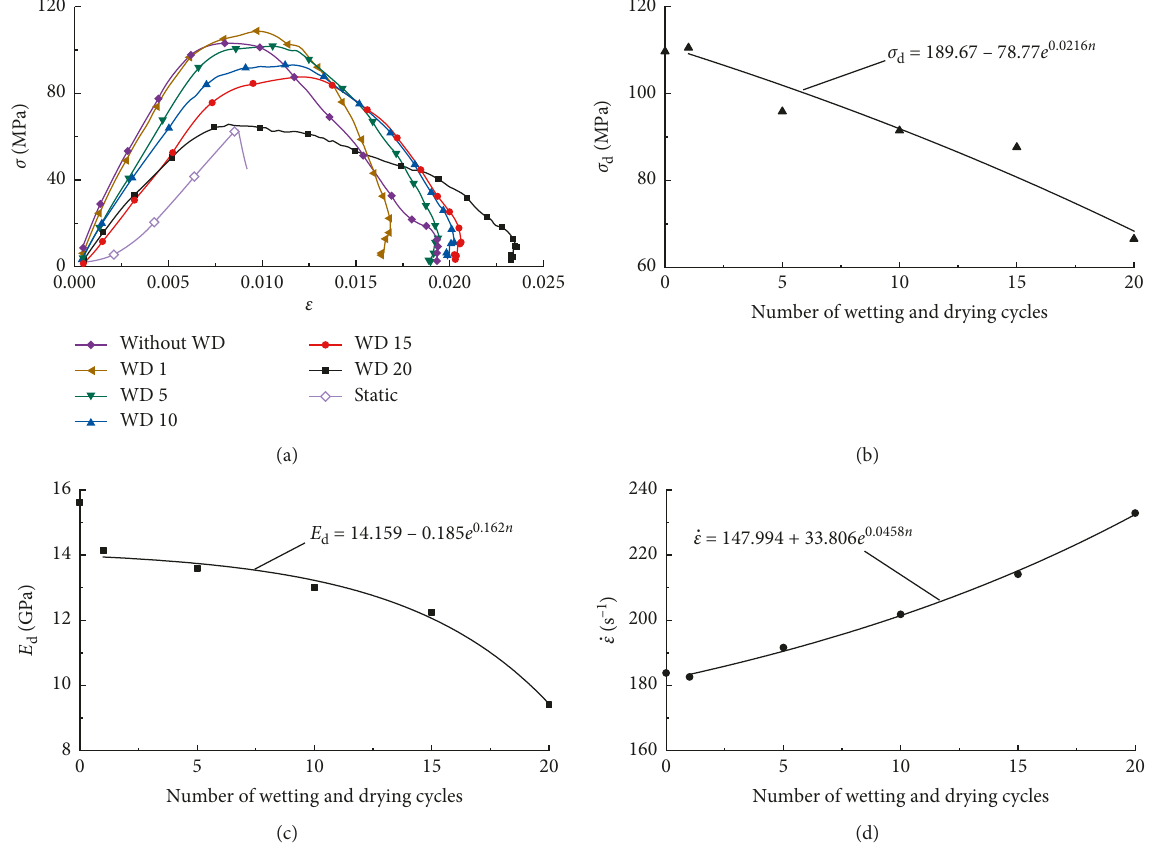
Figure 8: Dynamic uniaxial compressive characteristics variation versus wetting and drying cycles. (a) Dynamic compressive stress-strain curve. (b) Dynamic uniaxial compressive strength. (c) Dynamic elastic modulus. (d) Average strain rate. compressive strength, the dynamic elastic modulus shows a Figure 8(d). Compared with dynamic uniaxial compressive 13.4% decrease after 15 cycles of wetting and drying and a strength after 1 cycle of wetting and drying, dynamic uni- 33.5% decrease after 20 cycles of wetting and drying. Re- axial compressive strength presents a 20.7% decrease after 15 versely, the average strain rate displays a 17.2% increase after cycles of wetting and drying and a 39.8% decrease after 20 15 cycles of wetting and drying and a 27.5% increase after 20 cycles of wetting and drying. Similar to dynamic uniaxial